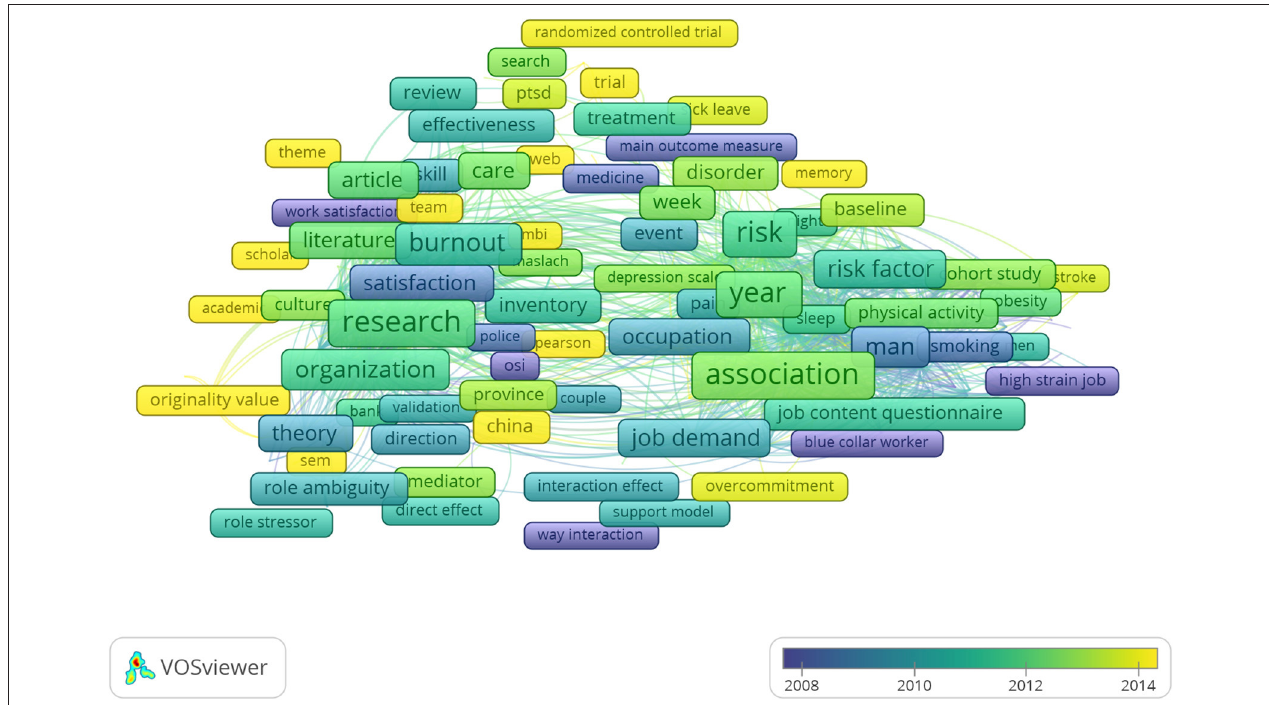
FIGURE 6 | A term co-occurrence map according to terms from the title and abstract fields. Indicators show the current publications from purple to yellow. The size of the frames represents the frequency of appearance as the keywords. The distance between the two frames indicates their correlation. The closer the distance, the more similar the